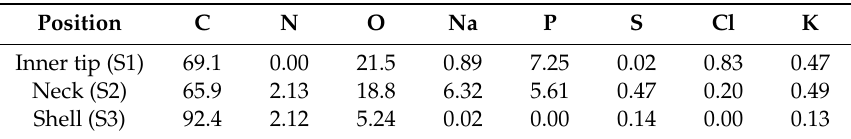
Figure 9. Dark field STEM image of Sample 2 — a carbon finger produced by burning spaghetti that had been boiled in salt water. Table 2. Elemental composition (atomic%) in finger originating from combusted spaghetti previously cooked in salt water — Sample 2 (See Figure 9).